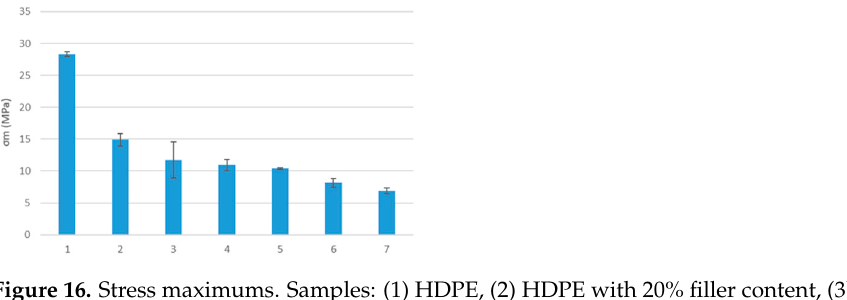
Figure 16. Stress maximums. Samples: (1) HDPE, (2) HDPE with 20% filler content, (3) HDPE with 40% filler content, (4) HDPE with 50% filler content, (5) HDPE with 60% filler content, (6) HDPE with filler content 70%, (7) HDPE with a filler content of 80%.